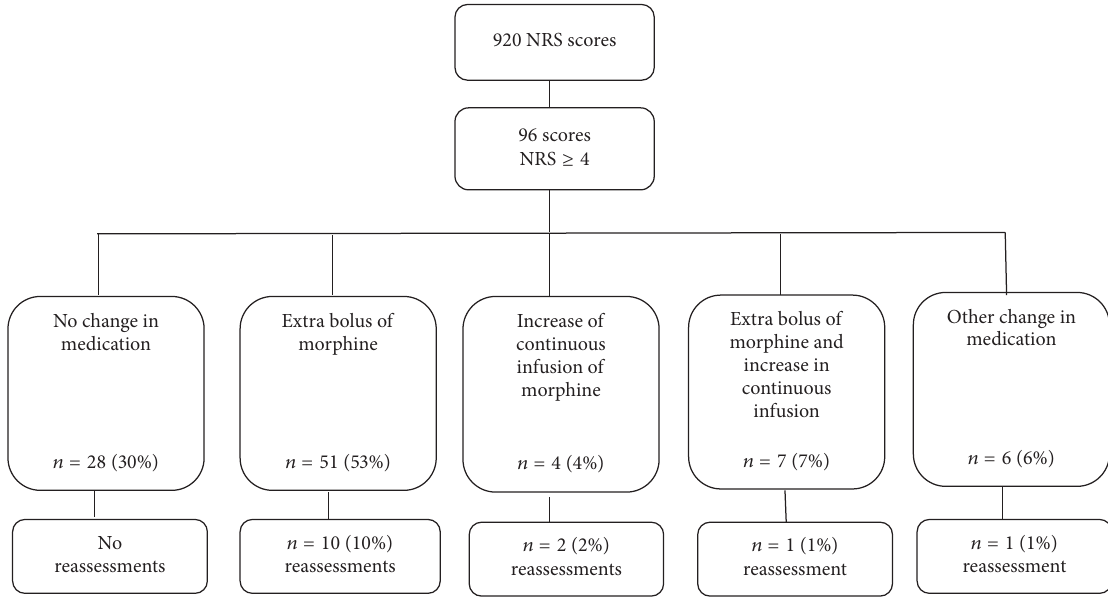
Figure 2: Actions upon pain scores with NRS ≥ 4. NRS: numeric rating